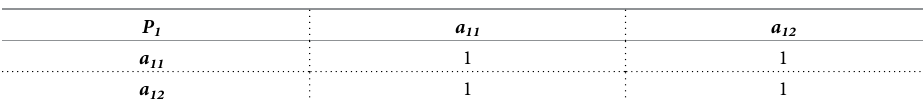
Table 6. P 1 ⬅ { a 11 , a 12